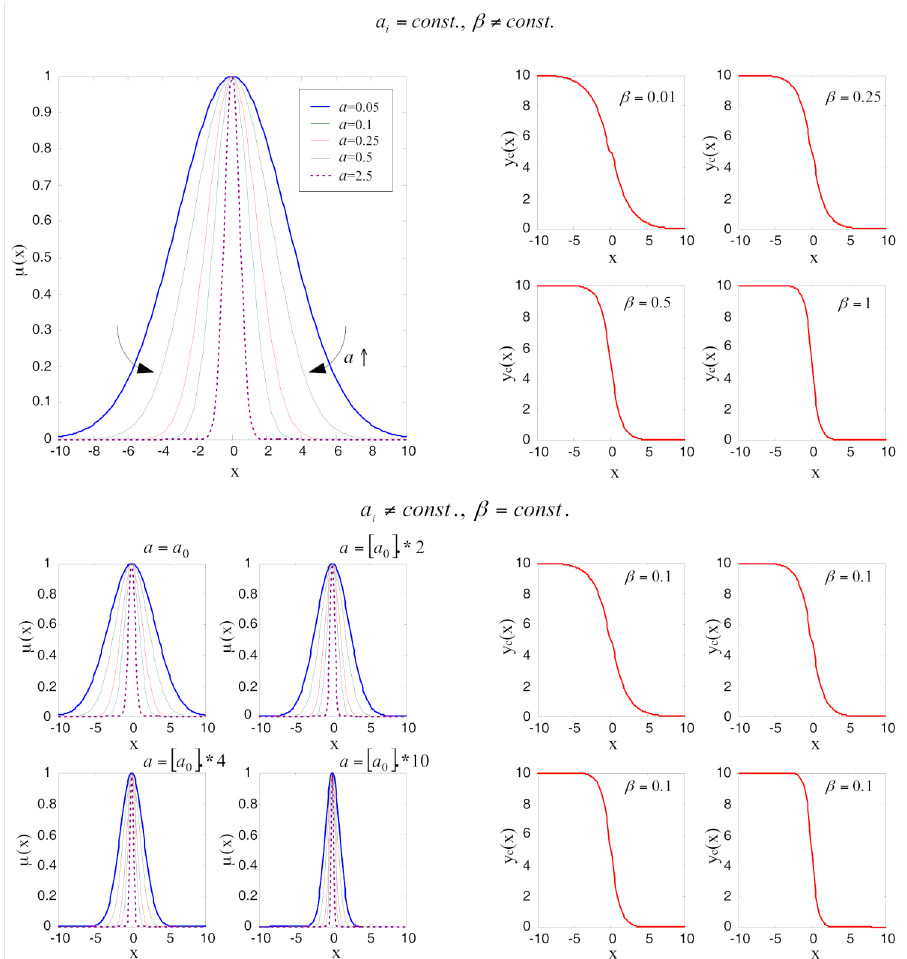
Figure 5. The graphic presentation of different distributions of input fuzzy sets and output control function for different off-line setting a and β